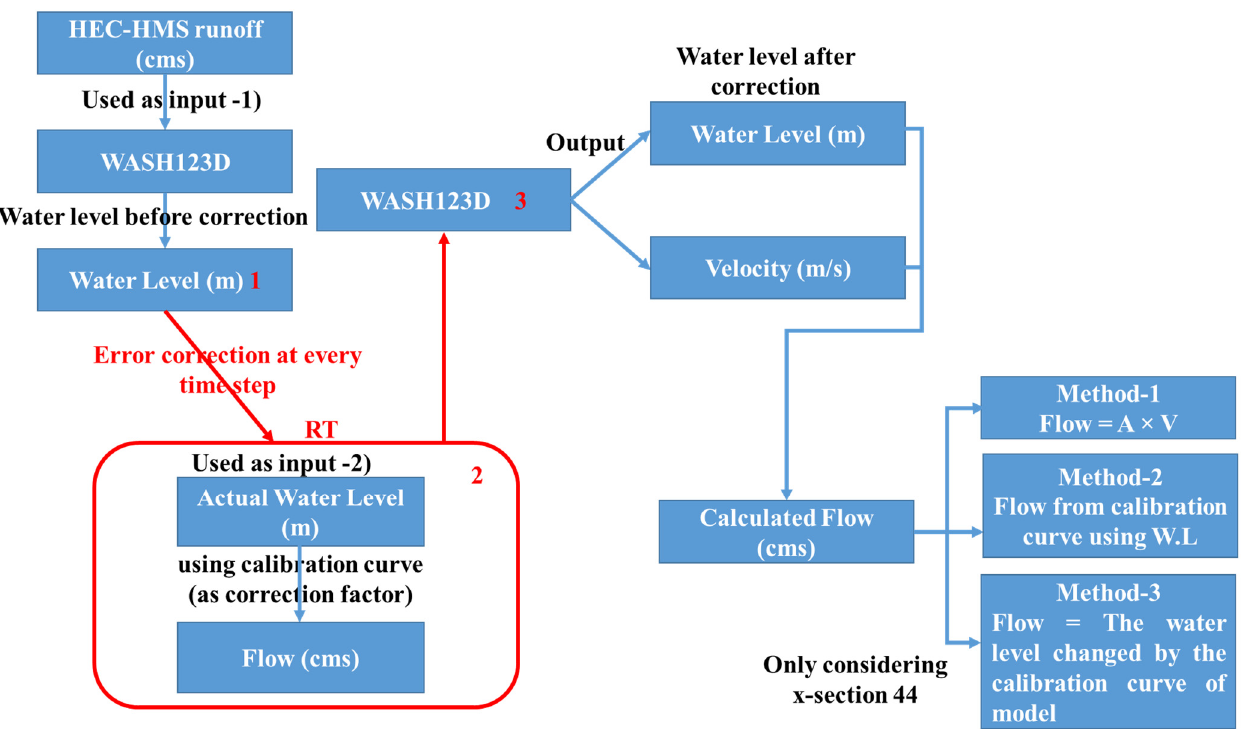
Figure 8. QPF rainfall calculation method.